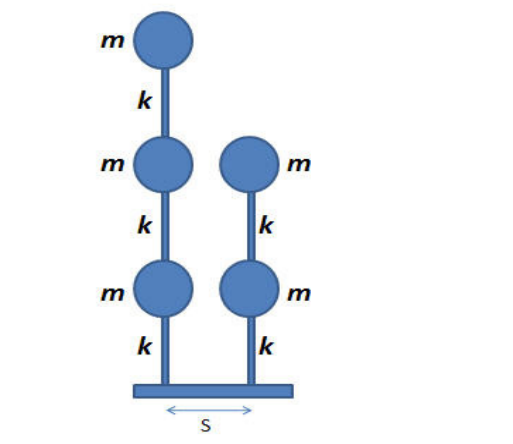
Figure 2. Model of three-story building located close to a two-story structure (arrangement 3-2).